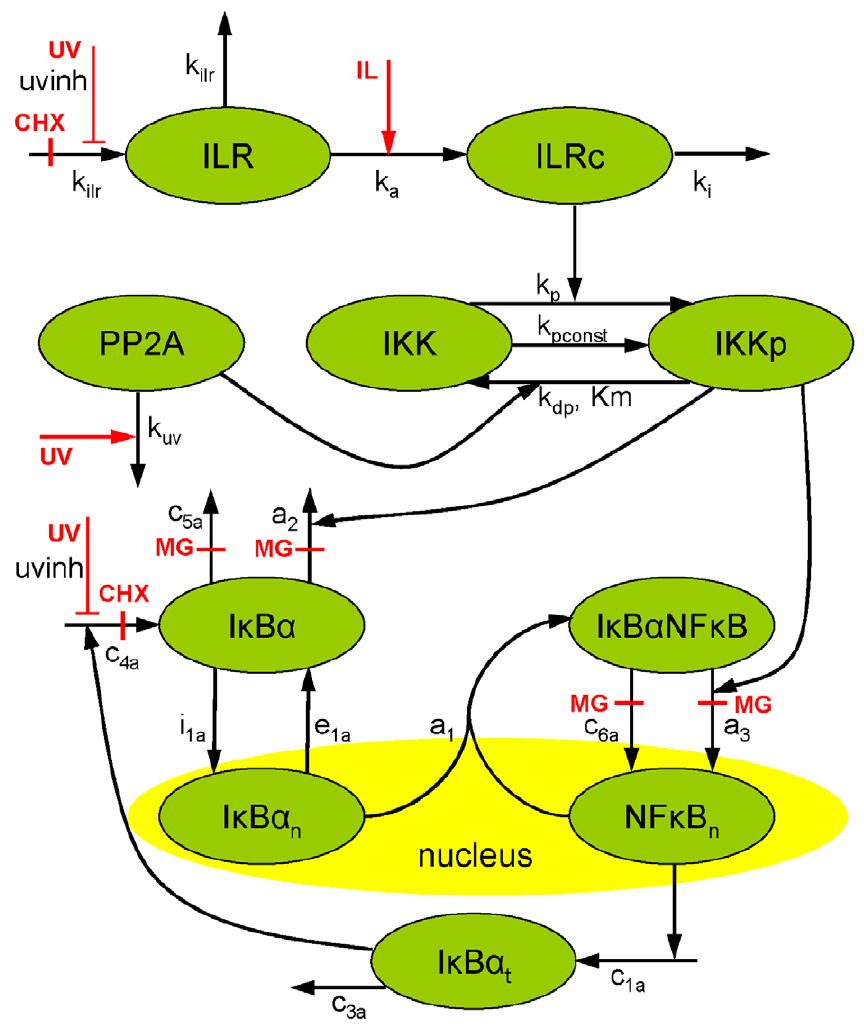
Figure 1. Schematic representation of the reference model. System variables are depicted in green, inputs are depicted in red. Abbreviations and parameter names are explained in Tables S1 and S2. The model variants lacking translational inhibition or PP2Ac deactivation are implemented by setting uvinh =0 or k uv =0, respectively.